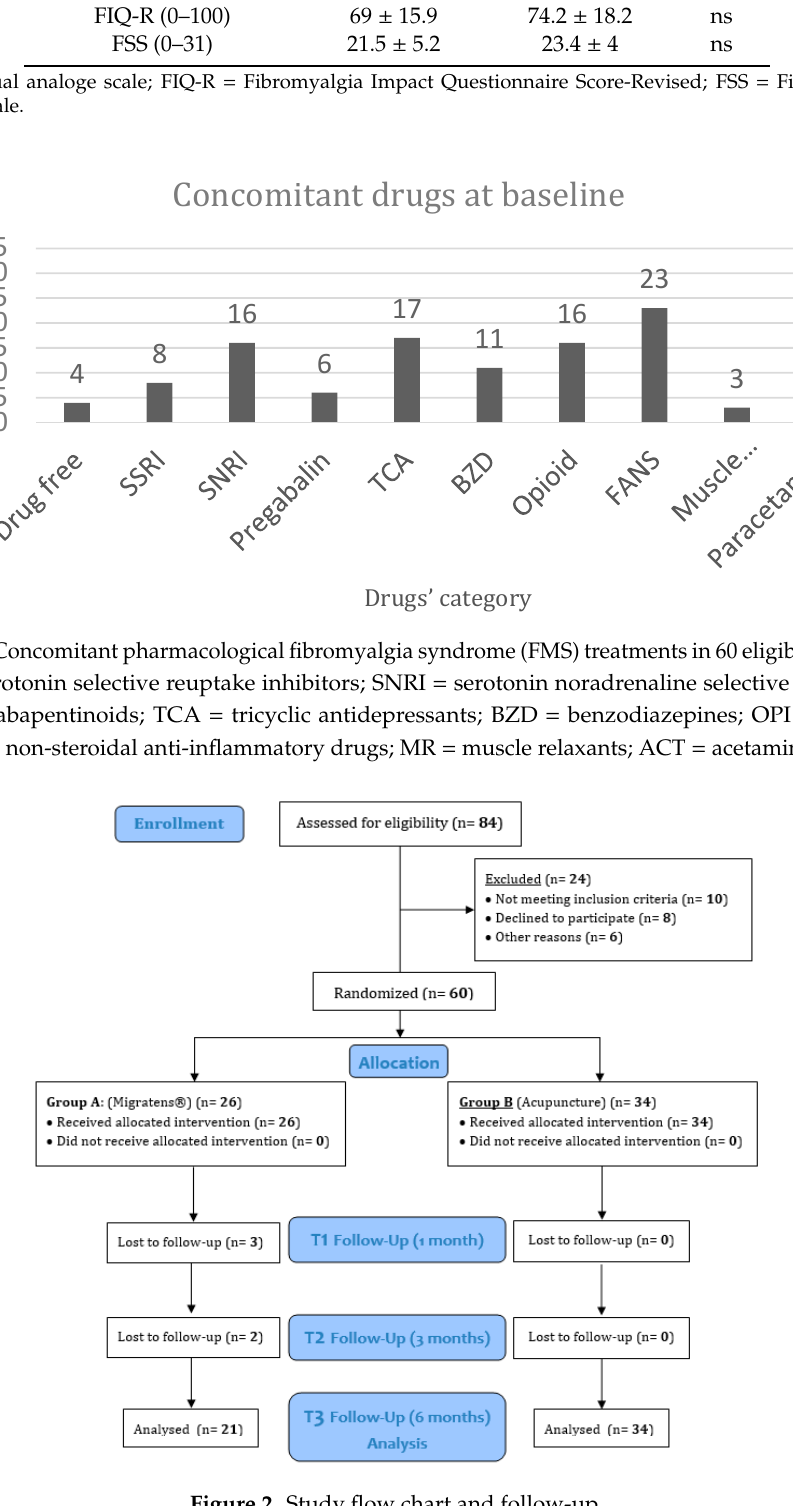
Figure 2. Study flow chart and follow-up. Table 1. Patient demographics and baseline characteristics.